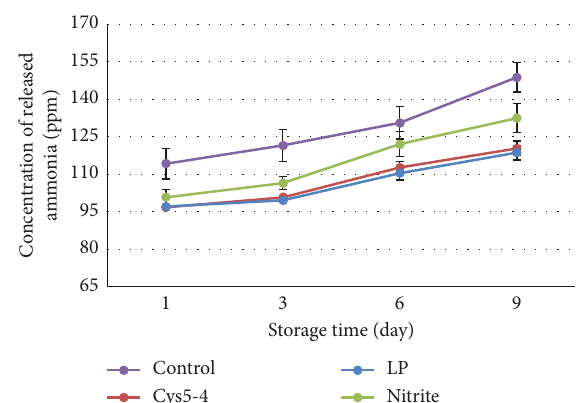
Figure 2: Changes in ammonia released during the storage time. Cys5-4: meat treated with Cys5-4; LP: meat treated with LP, nitrite: meat treated with nitrite. Control: untreated meat; Cys5-4: L. plantarum UTNCys5-4; LP: L. plantarum ATCC 8014.